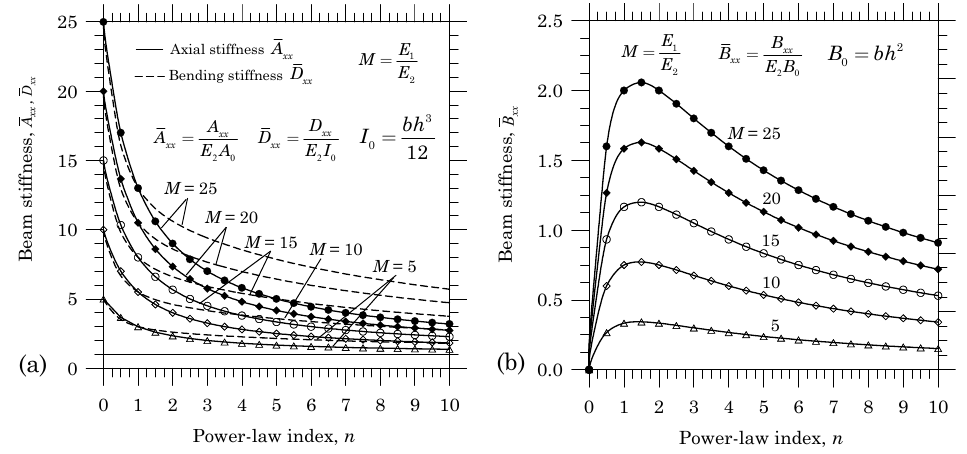
¯ B xx ( n ) = B xx / E 2 B 0 as functions of